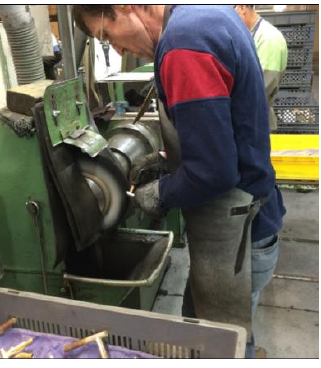
Figure 12 . Manual Polishing process